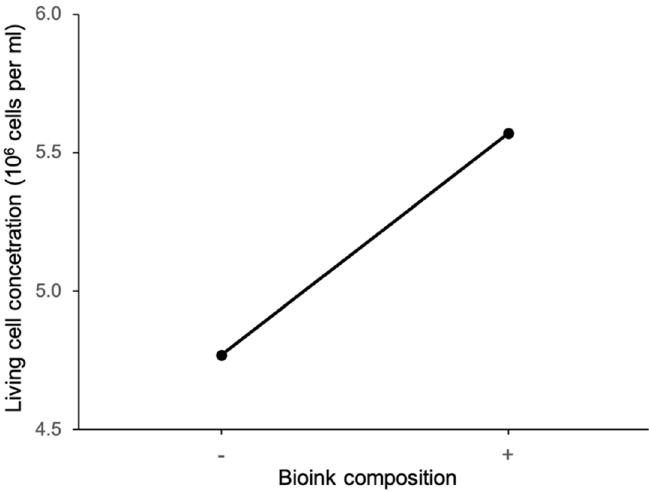
Figure 13. Main effect of bioink composition on living cell concentration.